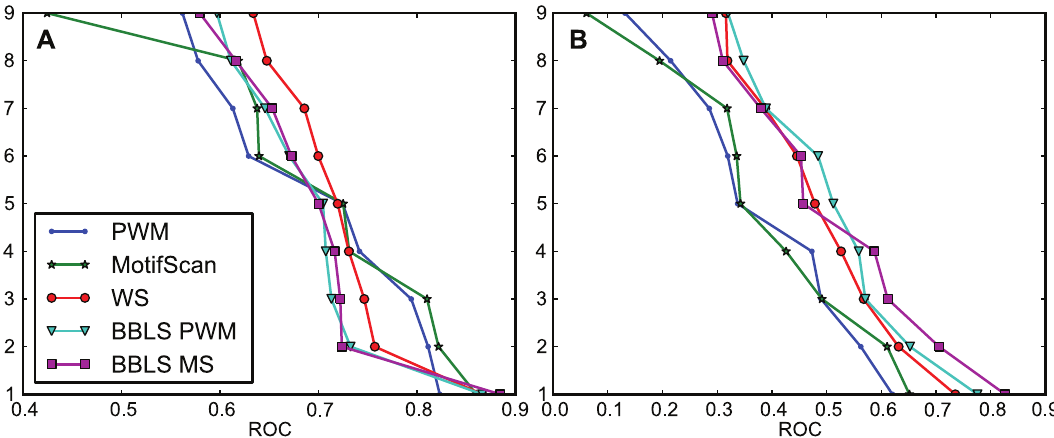
Figure 2. Cumulative ROC score on site and promoter benchmarks. The cumulative number of TF datasets for which a method has a ROC AUC of more than a given value on the A ) site and B ) promoter benchmark. Each line represents a method and shows for each point along the y-axis how many datasets that have at least the ROC score given on the x-axis. The ROC score, or area under the ROC curve (AUC), is a measure of accuracy that summarizes the true-positive and false-positive rate and the implied trade-offs at all score thresholds.